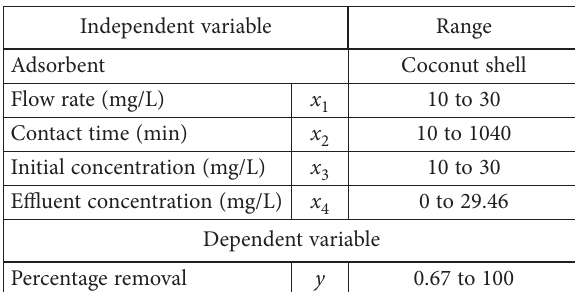
Table 7. Data description for MLR and GA analyses